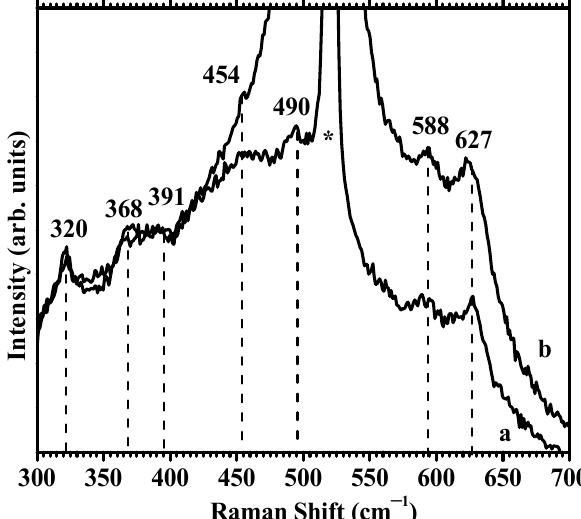
Figure 9. Raman spectra of ( a ) ITO film on Si and ( b ) ITO:Zn film on Si. Raman vibration modes of cubic In 2 O 3 have been reported at 308, 365, 471, 504, 637, and 707 cm − 1 [70], at 307, 368, 497, and 632 cm − 1 [71], at 307 366, 497, and 630 cm − 1 [72], at 307, 366, 407, 495, 560, and 630 cm − 1 [73], and at 307, 366, 495, 517, and 631 cm − 1 [74]. Re ‐ ported modes correspond with the intense modes 1–7 and the weak modes 2–3–5 ob ‐ served here, with slightly displaced positions compared to cubic In 2 O 3 . For tin ‐ doped ITO, additional vibration modes at 433–451 and 584 cm − 1 (modes 4–6 observed here) have been reported [58,74].